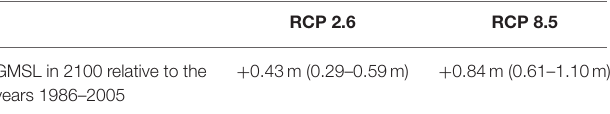
TABLE 1 | GMSL rise estimates depending on different RCP scenarios according to the Special Report on the Ocean and cryosphere in a changing climate (Oppenheimer et al.,